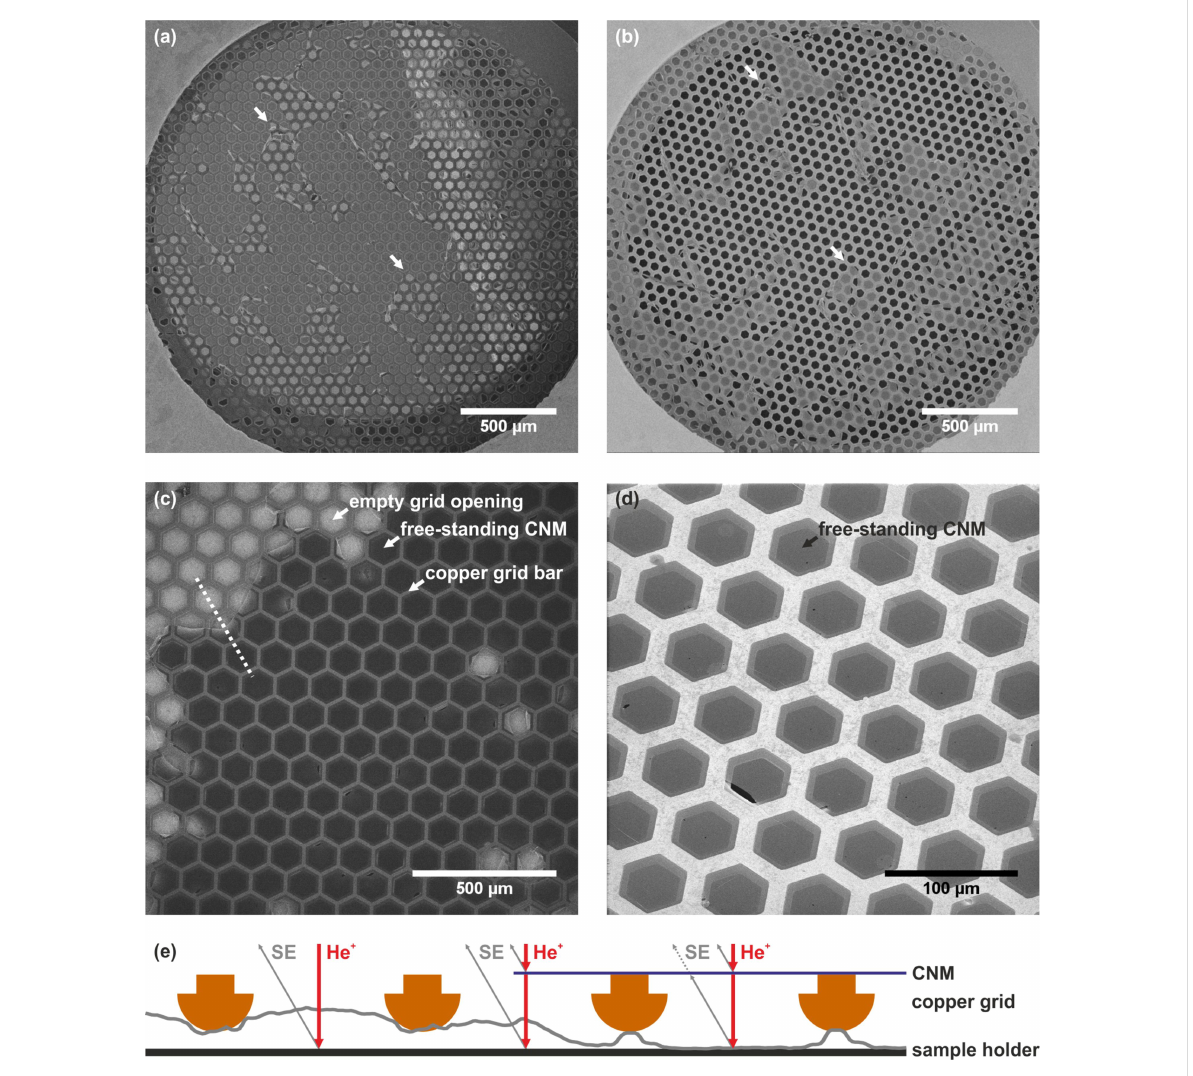
Figure 1: (a, b) HIM images of freestanding CNMs on TEM grids, illustrating the importance of the background. Both images show the same sample mounted differently. The arrows point to the same positions as a guide to the eye. (c) CNMs on a TEM grid with a bright background and substantial membrane charging. (d) CNMs are imaged on a dark background with negligible membrane charging. (e) Schematic cross-section and superim- posed line profile of the image greyscale values along the dotted line in (c) with the primary He + beam and secondary electrons emitted from the CNM and the sample holder depicted at three exemplary locations. The values of the line profile (grey curve) are a measure of the amount of detected sec- ondary electrons. Detailed information on all HIM images are given in Supporting Information File 1, Tables S1 and